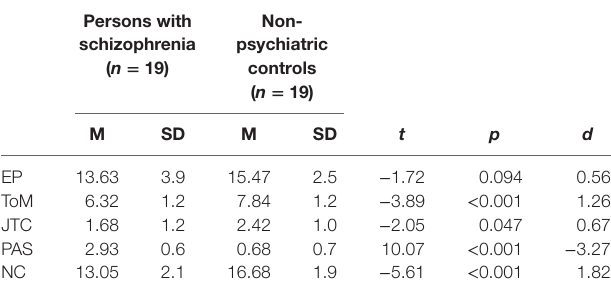
TaBle 2 | Descriptive statistics and test–retest reliability of C-FEIT and C-SCSQ ( N = 17). subscales